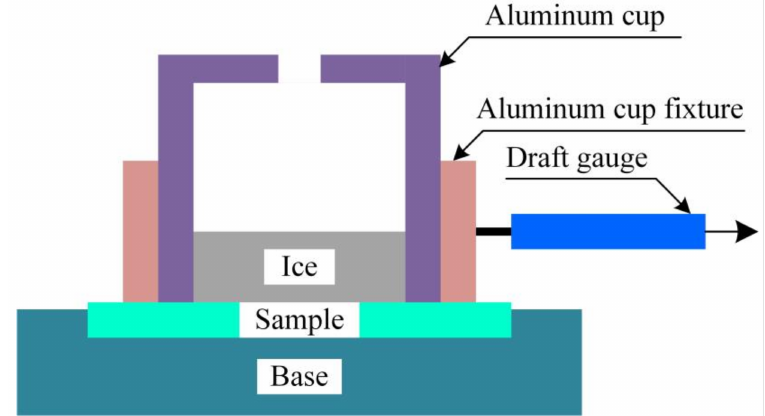
Figure 8. Schematic diagram of the ice adhesion strength test.